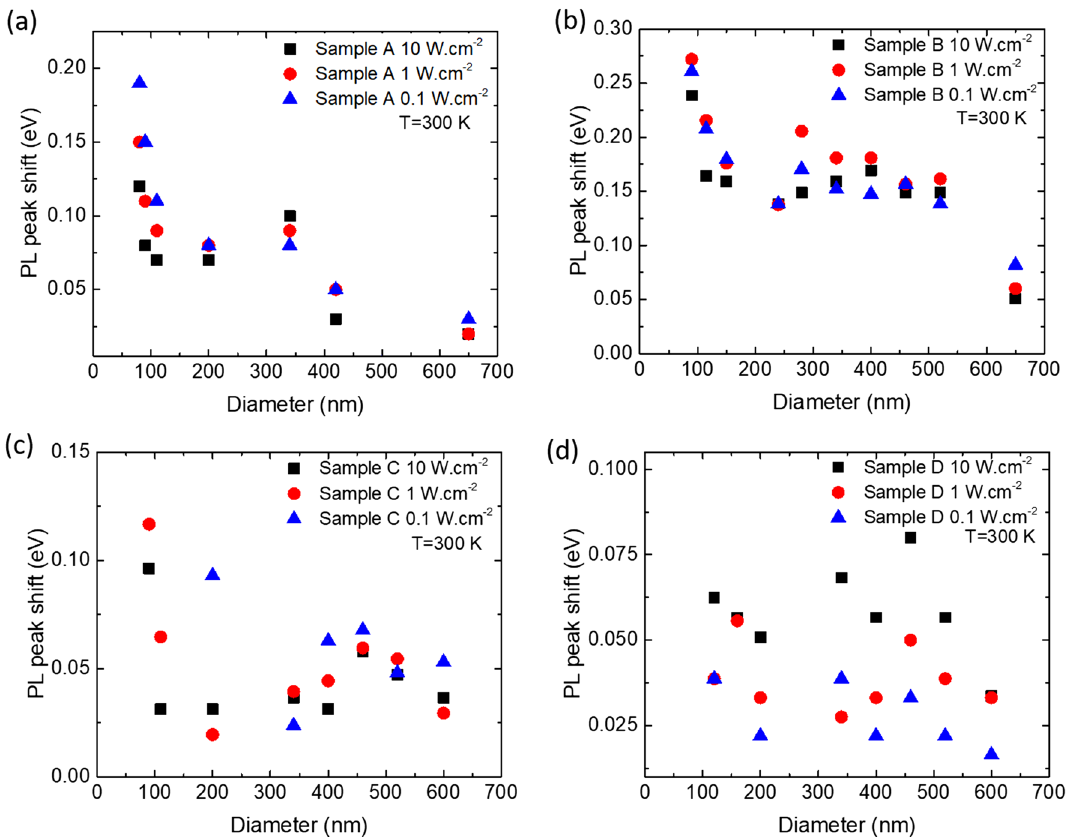
Figure 4. RT-PL peak shift of threefold InGaN/GaN MWQs with different indium concentration and thicknesses in GaN NRds for excitation powers of P = 0.1 W cm −2 , 1 W cm −2 , 10 W cm −2 . ( a ) Sample A. ( b ) Sample B. ( c ) Sample C. ( d ) Sample D.